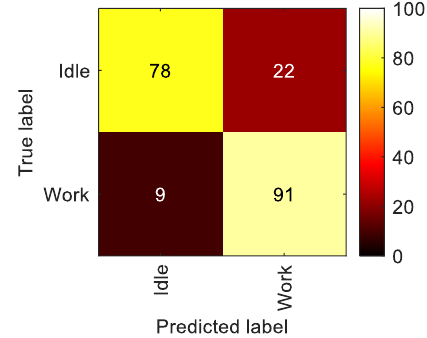
Figure A3. LoD3 confusion matrix for the MLP: ( a ) drill, ( b ) reinforce; ( c ) concrete; and ( d ) secondary processes.